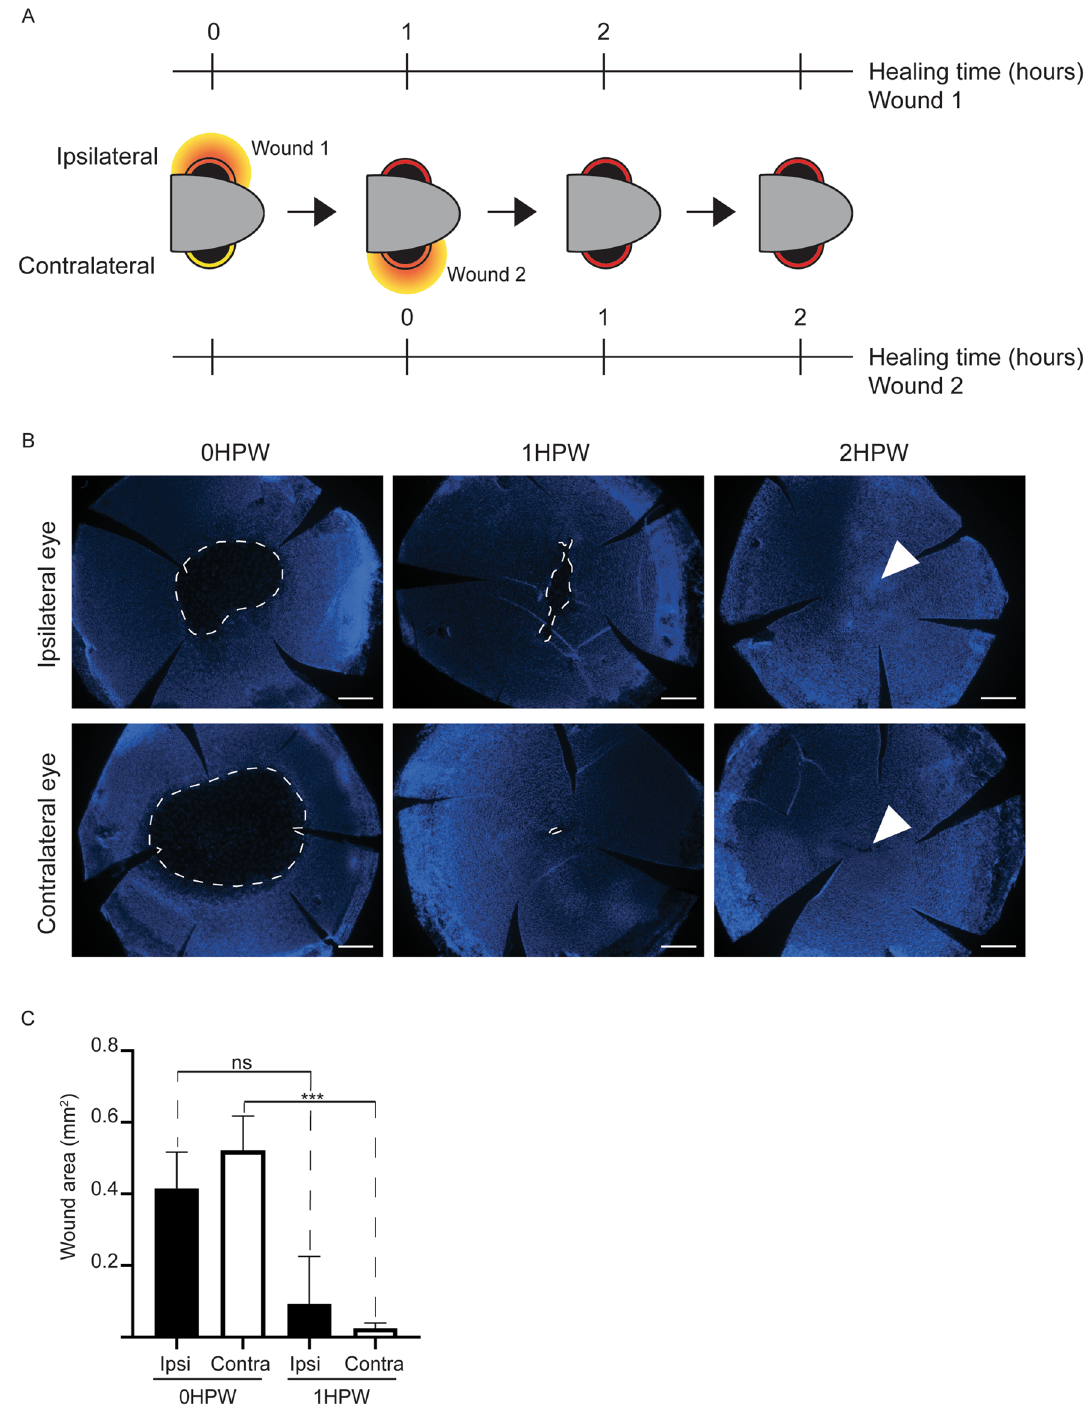
Figure 12. Accelerated wound closure on the contralateral cornea after abrasion. ( A ) A schematic presentation of the experiment. The second wound, on the contralateral side is performed 1HPW. Each wound closure is followed during 2 h. ( B ) Representative images of the cornea of either the ipsilateral or contralateral eye at 0, 1, and 2HPW (Hoechst-staining). Dashed line indicates wound border, arrowhead points to wound site in a closed wound. The wound on the contralateral side is closed by 1 HPW, while the wound is still largely open on the ipsilateral cornea at 1HPW. ( C ) Quantification of the wound area on the right and on the left side at 1 or 2HP confirms the faster closure on the contralateral eye. Data represent mean + stdev, P *** < 0.001, n = 5–6 per group. Kruskal–Wallis test followed by Dunn’s test for multiple comparisons. HPW: hours post-wound. Scale bars: 200